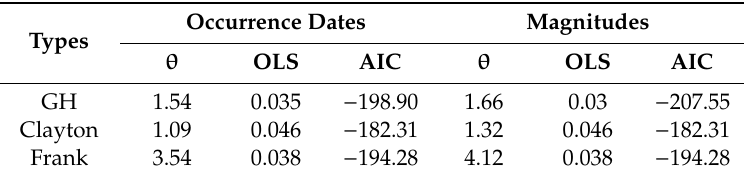
Table 6. Parameter estimation and fitting results for the joint distribution of flood occurrence dates and magnitudes in the reference